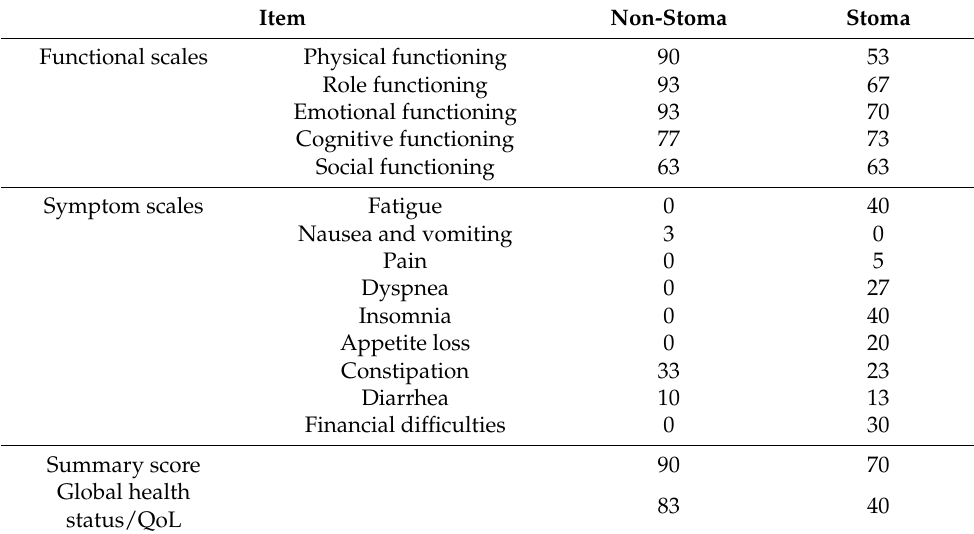
Table 3. QoL evaluated using the EORTC QLQ-30 (version